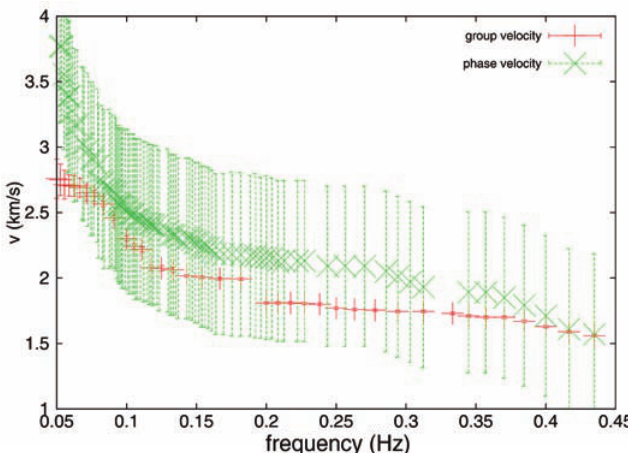
Figure 5. Average phase-velocity and group-velocity dispersion curves obtained by applying the p - ~ transform and MFT, respectively, as indicated.